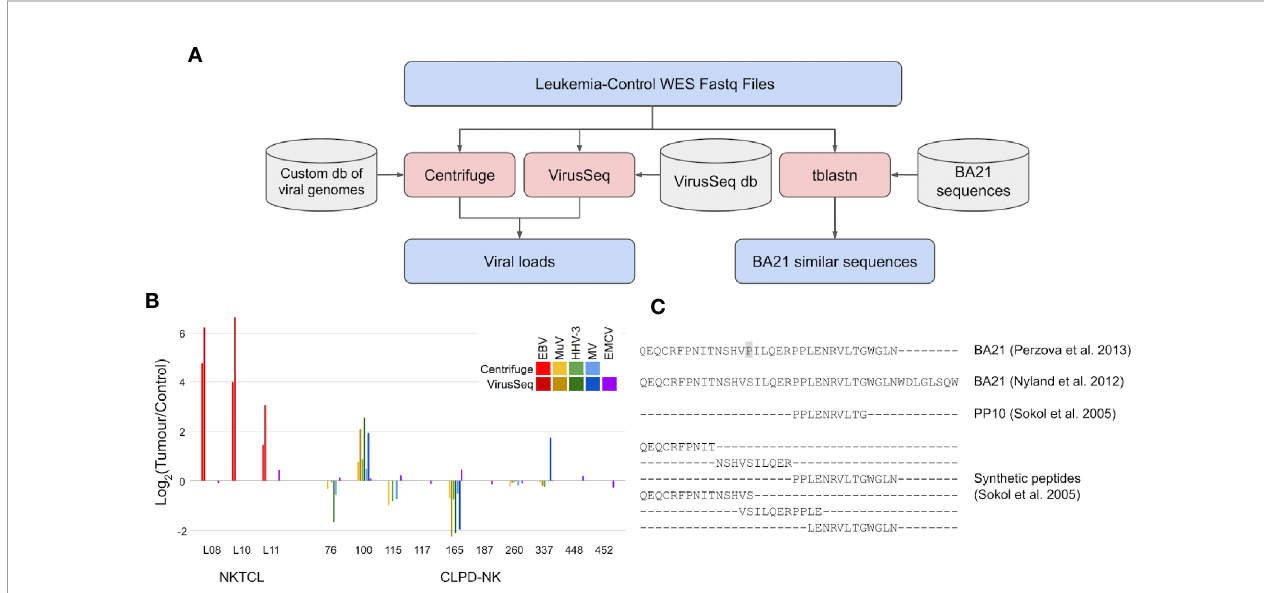
FIGURE 1 | Search for viral load and neoantigens similar to BA21 in WES data of CLPD-NK patients. (A) Analyses work fl ow for viral load and BA21 neoantigens. Files are indicated in blue, bioinformatic tools in red and databases in grey. (B) Load of viral sequences detected by Centrifuge and VirusSeq in tumor and control WES data of patients with NKTCL (11) and with CLPD-NK (13); for each patient, the viral load is expressed as Log2 of CPM ratio in tumor versus control samples; EBV, Epstein Barr virus, MuV, mumps virus, HHV-3, human alphaherpesvirus 3, MV, measles virus, EMCV, encephalomyocarditis virus; (C) Alignment of BA21 antigen sequences collected from literature (14, 15), of the shortest antigenic peptide PP10 and of other synthetic peptides covering BA21 sequence (16) that were compared with WES data to identify